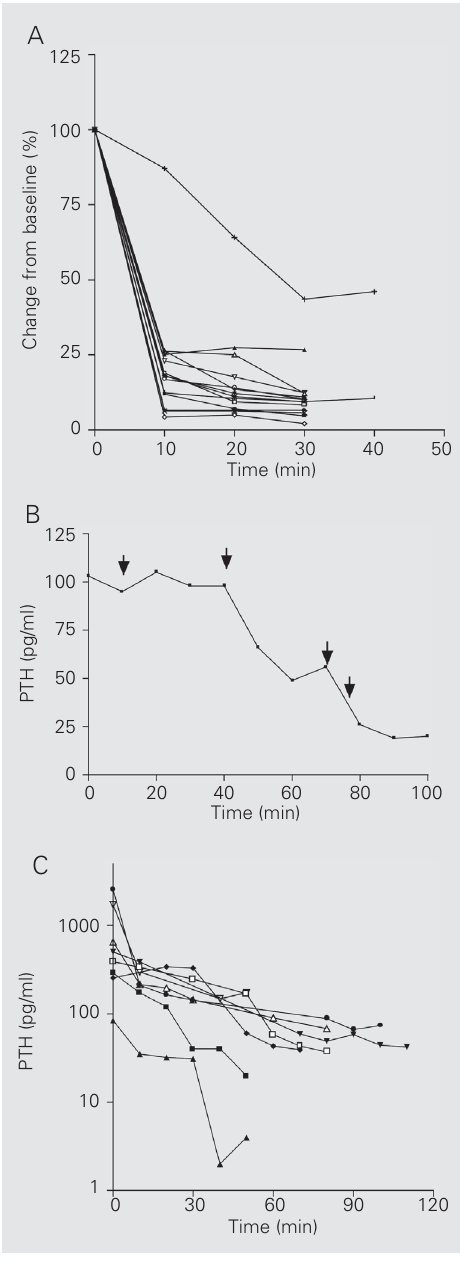
Figure 2. Intraoperative circulat- ing concentrations of intact para- thyroid hormone (PTH) during parathyroid gland resection. In- tact PTH was determined by the 9-min Elecsys assay system. A , Reduction of intact PTH in 14 primary hyperparathyroid pa- tients with a single adenoma. Data are reported as percent. B , Reduction of intact PTH (pg/ml) in primary hyperparathyroid pa- tients with multiglandular dis- ease. Arrows indicate parathy- roid gland resection. C , Intact PTH concentration (pg/ml) of 8 tertiary hyperparathyroid pa-